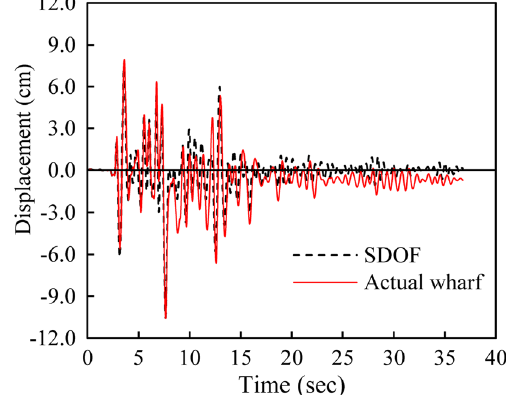
Fig. 6 Displacement demands for case study I